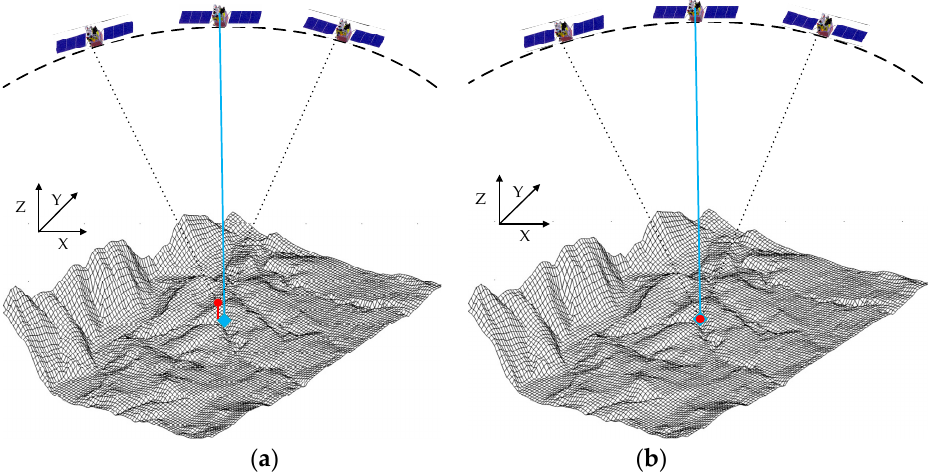
Figure 3. Schematic diagram for improving the elevation accuracy of stereo images with the laser range constraint. Geometric relation between stereo images and laser ranging data ( a ) before and ( b ) after the combined adjustment.